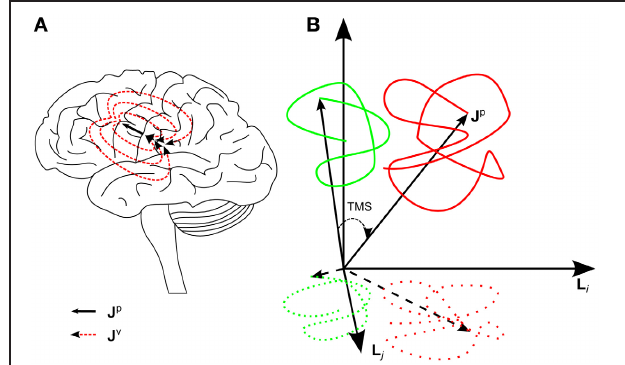
FIGURE 1 | (A) The black arrow represents one primary current source, a flow of ions in synapses in the left primary motor cortex. The dashed red lines represent the returning volume current. J p ( r ) describes the whole primary current distribution in the brain. (B) A schematic image of the hypothesis concerning the effect of TMS on the brain state. The green and red curves correspond to pre- and post-TMS brain-state trajectories, respectively. The spontaneous activity draws a trajectory in a certain region. TMS shifts the brain state to a new region in the state space. Furthermore, the brain state fluctuates more after TMS because of the increased free energy until the state gradually returns to the original set of spontaneous states. The projection of these effects can be seen in the EEG signal space, spanned by channels i and j . In the signal space, the trajectories are measured only at discrete time points, which is emphasized with dotted